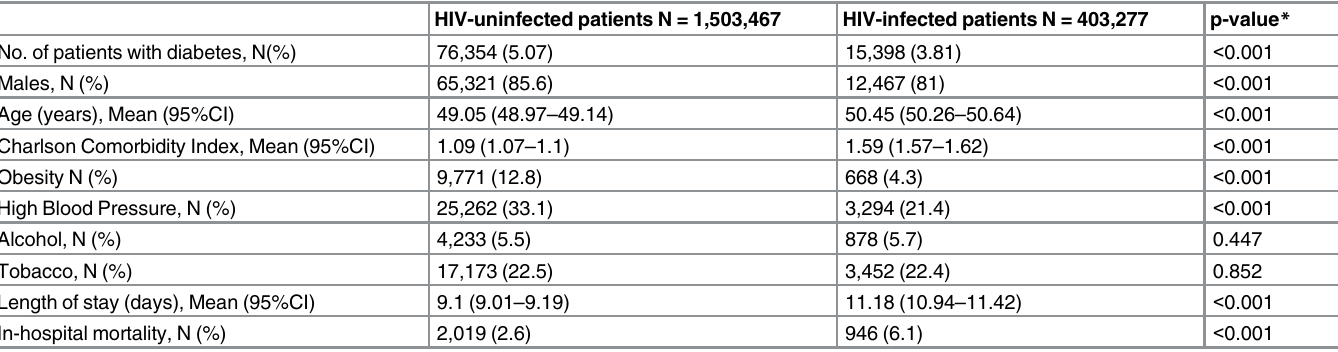
Table 1. Clinical characteristics, risk factors and outcomes of patients admitted with diabetes stratified by HIV status in Spain, 1997 – 2012. HIV-uninfected patients N = 1,503,467 HIV-infected patients N = 403,277 p-value